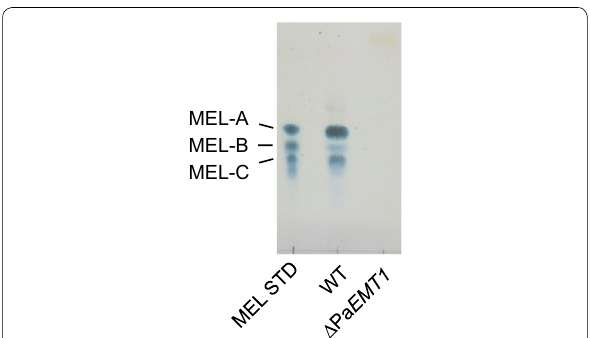
Fig. 1 Pa EMT1 deletion through homologous recombination in P. antarctica GB-4(0). Thin-layer chromatography (TLC) analysis of mannosylerythritol lipid (MEL) production by wild-type and Pa EMT1 ∆::NAT (∆Pa EMT1 ). MEL STD, MEL standard containing MEL-A, MEL-B and